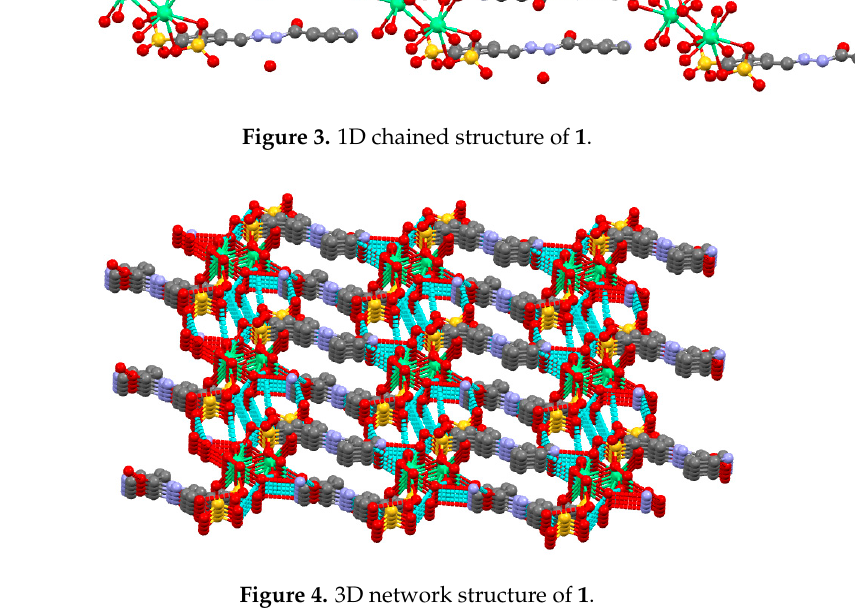
Figure 4. 3D network structure of 1 .